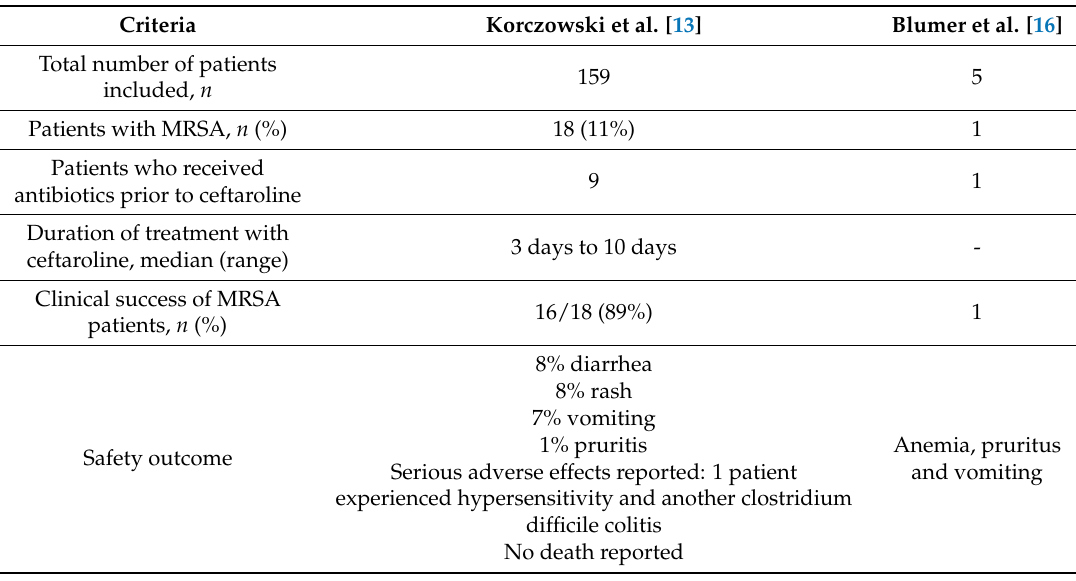
Table 2. Reports of trials that used ceftaroline to treat MRSA